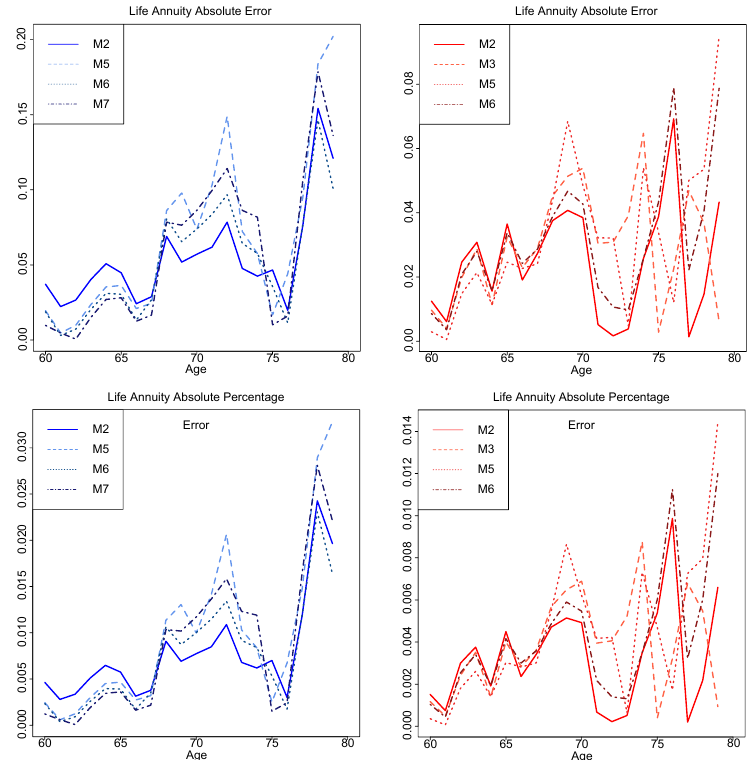
Figure 17. Absolute error and absolute percentage error values of life insurance and annuity products for the top four models in ranking for males ( left panels) and females ( right